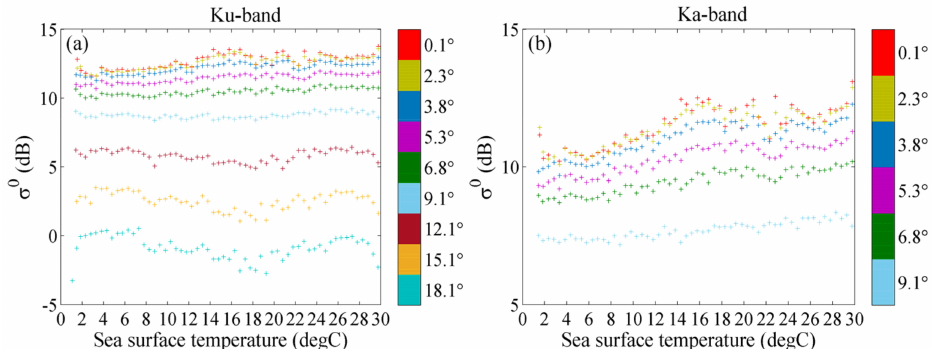
Figure 17. Mean values of binned ( a ) KuPR σ 0 , ( b ) KaPR σ 0 as functions of sea surface temperature for selected incidence angles.